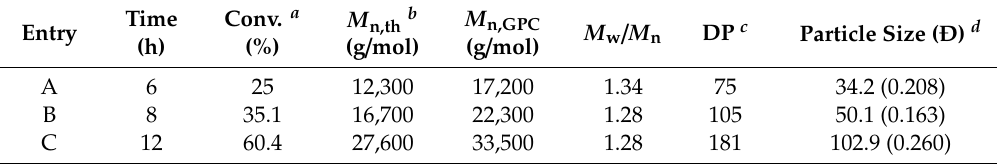
Table 2. Polymerization of HPMA via